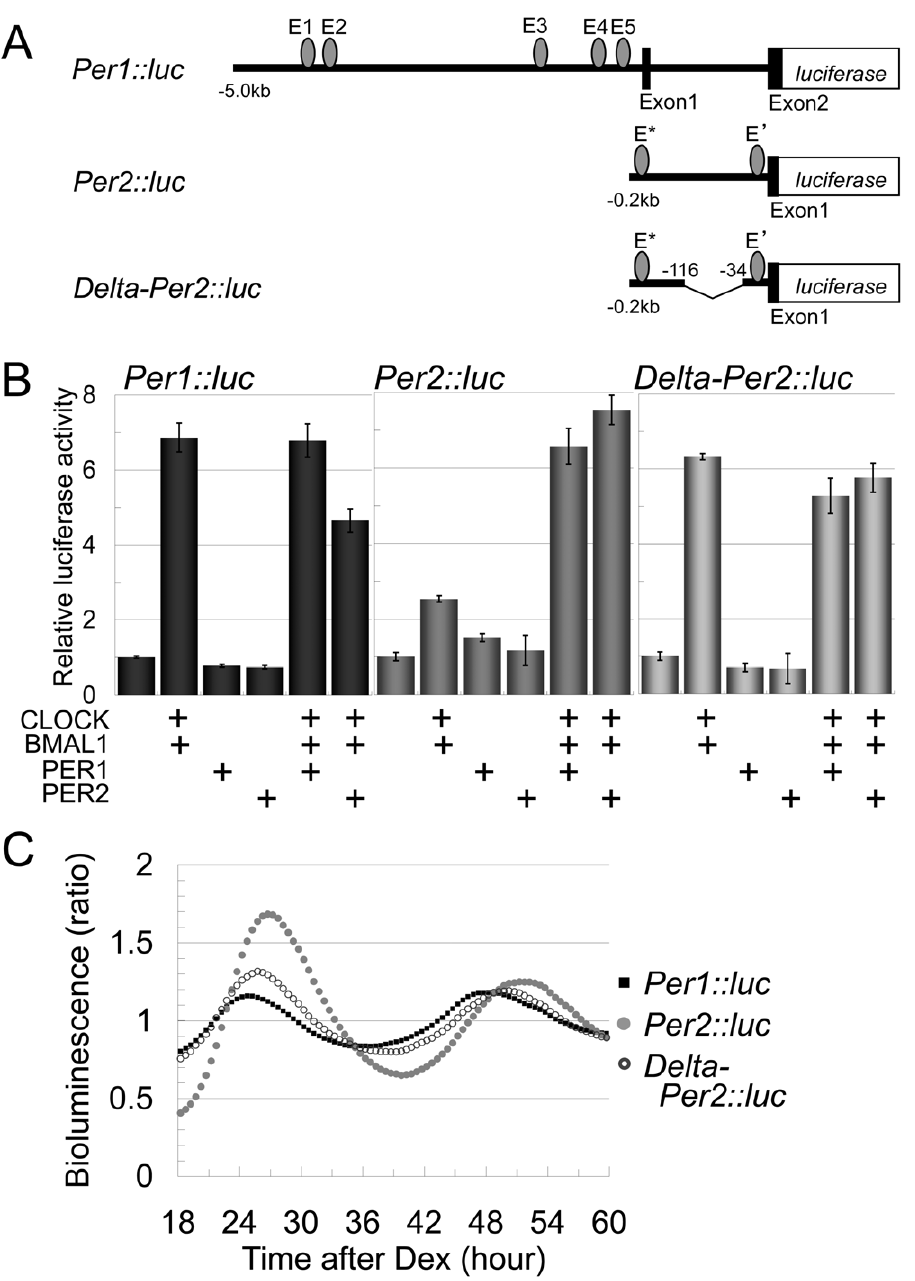
Figure 5. Per2 positive feedback regulation and its contribution to oscillatory phase delay invitro . (A) Schematics of Per1::luc , Per2::luc and delta-Per2 promoter driving luciferase reporter ( delta-Per2::luc ). Delta-Per2::luc does not contain the region between two E-box like elements (115- 35 bp upstream from transcription start site [5] ) that contributes to positive feedback regulation. (B) PER1 and PER2 co-transfection with CLOCK and BMAL1 induced only Per2 promoter activity. Left: Per1::luc , middle: Per2::luc , and right: delta-Per2::luc . Induction intensities of Per1::luc by CLOCK- BMAL1 were 6.86 6 0.38 without PER1/2, 6.78 6 0.44 with PER1, and 4.64 6 0.31 with PER2 in reference to the basal promoter activity. Induction intensities of Per2::luc by CLOCK-BMAL1 were 2.52 6 0.08 without PER1/2, 6.57 6 0.47 with PER1, and 7.53 6 0.39 with PER2 in reference to the basal promoter activity. Both PER1 and PER2 proteins significantly induced the Per2 promoter in the presence of CLOCK-BMAL1, but not Per1 promoter (Student’s t-test, P , 0.01). Induction intensities of delta-Per2::luc by CLOCK-BMAL1 were 6.32 6 0.19 without PER1/2, 5.27 6 0.14 with PER1, and 5.76 6 0.03 with PER2 in reference to the basal promoter activity, and there were no significant differences. Normalization was conducted with a pCIneo vector co-expression. Error bars indicate SEM determined from independent experiments in triplicate. (C) Representative bioluminescence oscillations of Per1::luc (square), Per2::luc (filled circle), and deleted-Per2::luc (open circle). The time difference from the Per1::luc to the Per2::luc expression peaks was 3.88 6 0.14 hours (Student’s t-test, P , 0.005). The phase of delta-Per2::luc was advanced by 2.86 6 0.39 hours (Student’s t-test, P , 0.01) compared with wild-type Per2::luc . Statistical data for the period and phase are described in the text and Table 1.